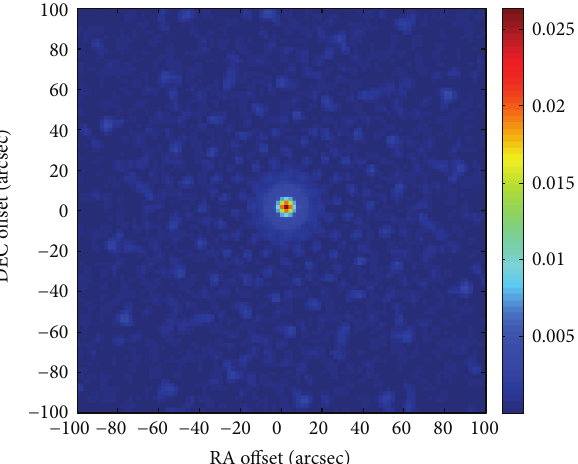
Figure 3: The natural weighting dirty beam of Figure